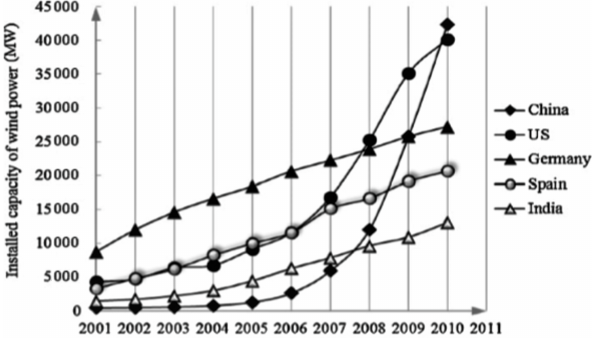
Figure 1. Global wind power capacity installed, GW, 1990–2015 (Wind Power Report, 2010).